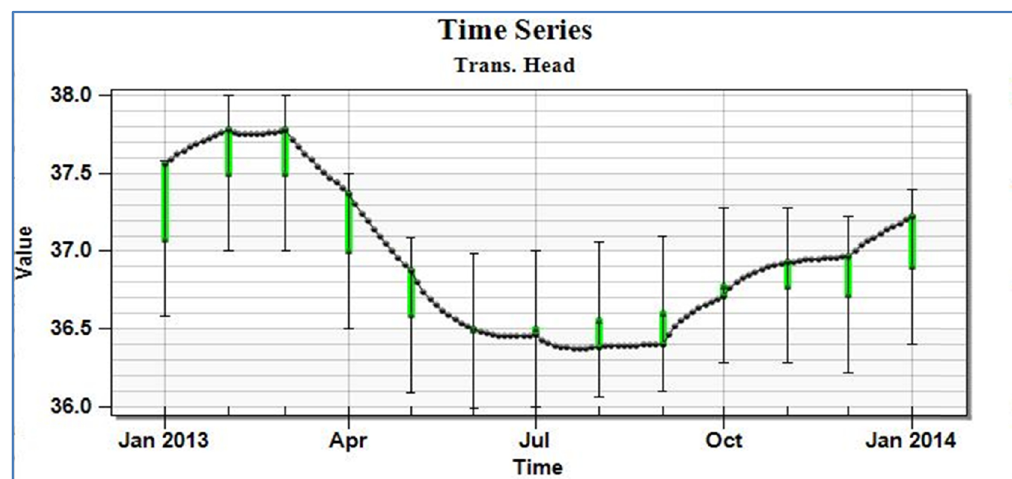
Figure 7: Elevation of groundwater in the observation well.